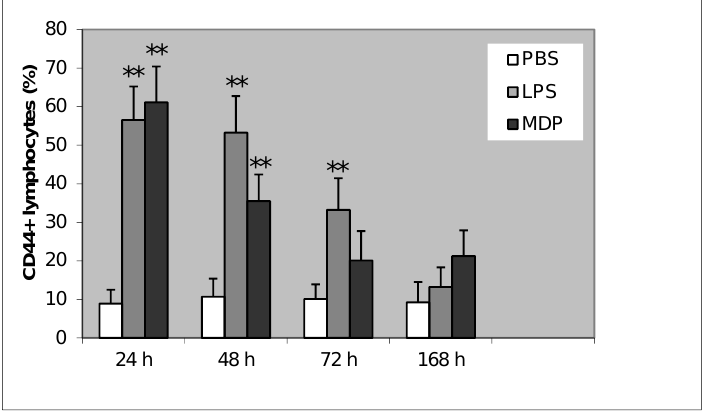
Figure 2. Proportion of CD44 + lymphocytes following induction of bovine mammary gland with PBS (control), LPS, and MDP. Statistically significant differences between the control (PBS) and LPS or MDP is marked with asterisks (** P < 0.01).